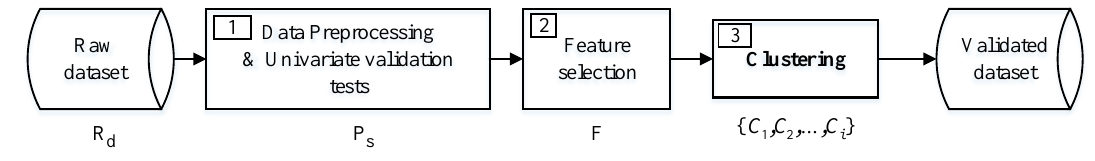
Figure 2. Off-line raw data validation